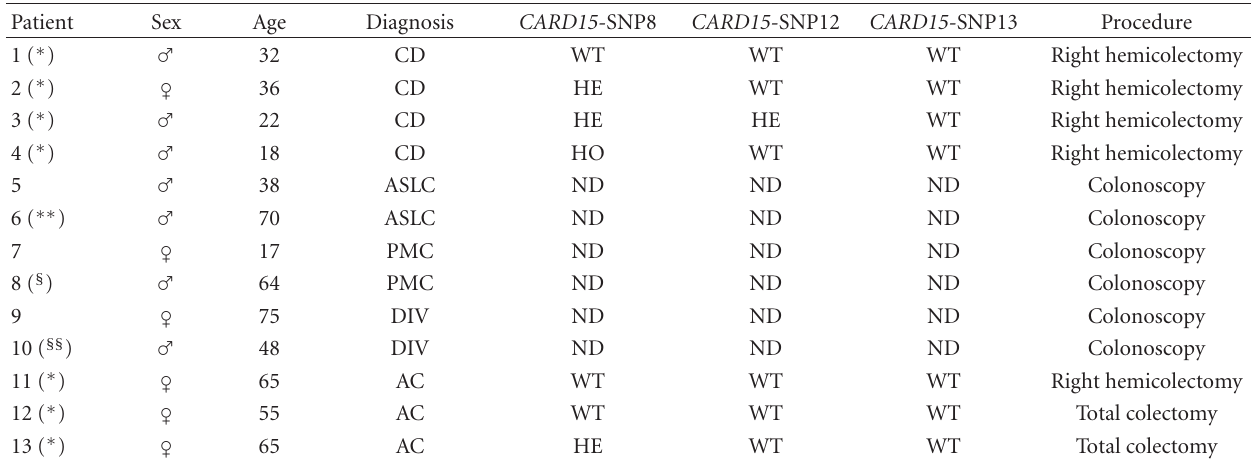
Table 1: Patient